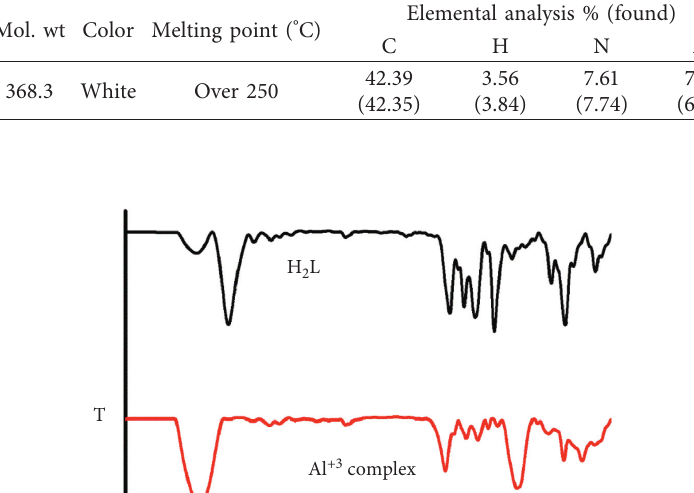
Table 1: The elemental analysis, molar conductance data, and physical properties of the Al +3 complex.